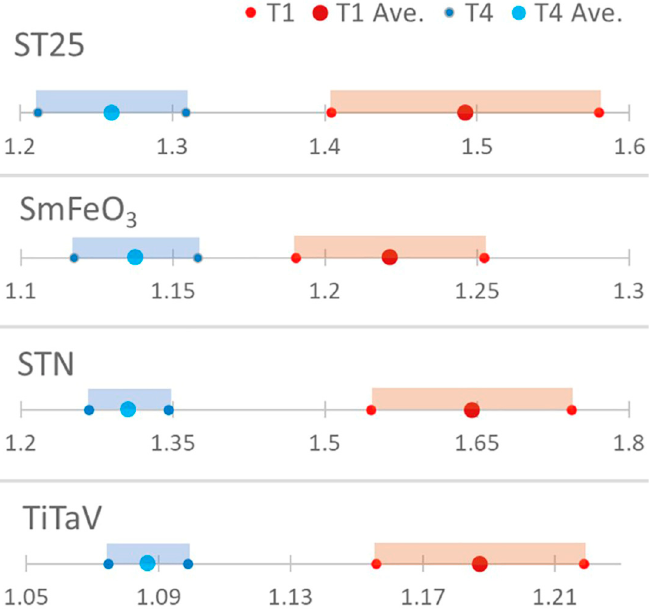
Figure 6. Confidence interval analysis. The statistical discrimination between T1 and T4 was evaluated by computing the confidence intervals by using the Student’s t -test ( n = 30 for T1 and n = 28 for T4).